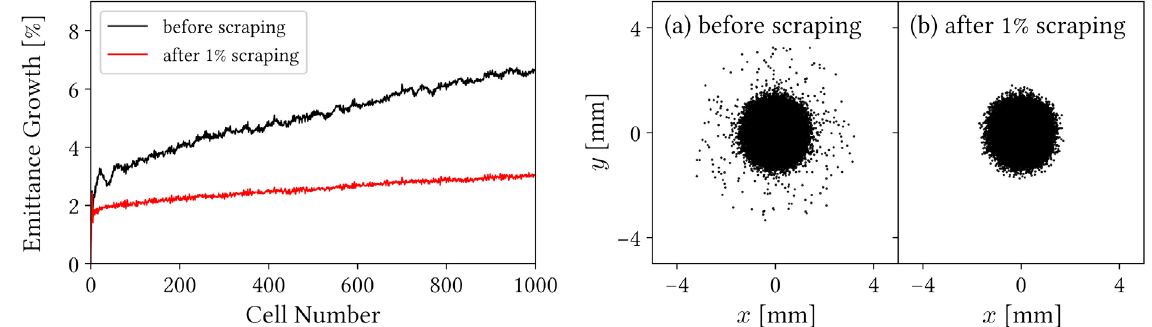
FIG. 22. Time evolution of the emittance growth of the Gaussian beam assumed in Fig. 21. The black solid line is the growth calculated from the whole beam (100% rms emittance). The red line is based on the truncated distribution in which one percent of tail particles are disregarded (99% rms emittance). A sudden jump of the emittance growth ð ∼ 2% Þ , which occurs within the first few AG cells, is due to the self-organization of the phase-space distribution triggered by a weak initial mismatch to the lattice. The final cross- sectional views of the beam before and after the 1% tail scraping are exhibited in the right